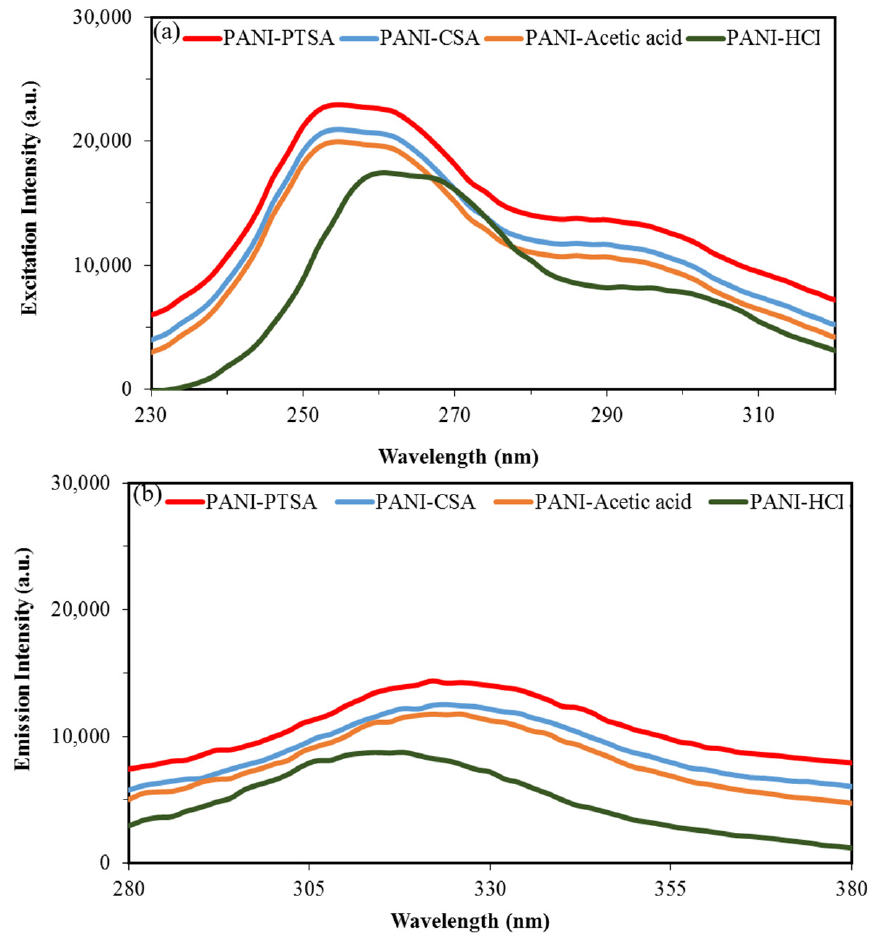
Figure 8. PL spectra of synthesized PANI samples. ( a ) Excitation photoluminescence peaks. ( b ) Emission photoluminescence peaks.